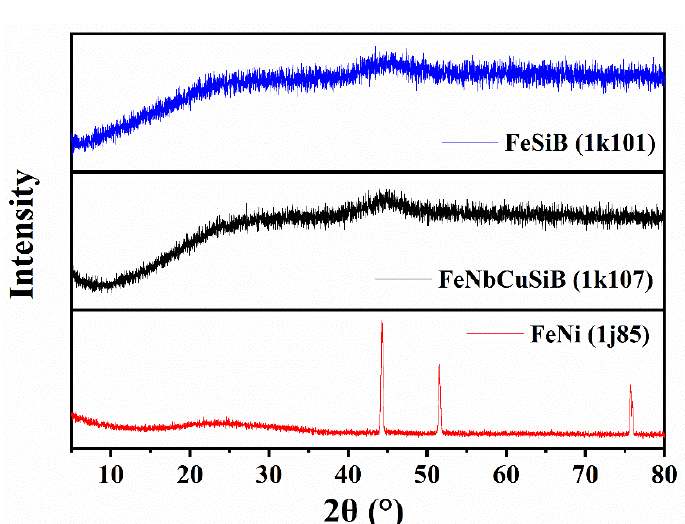
Figure 2. The XRD patterns of the Fe-based sheets.